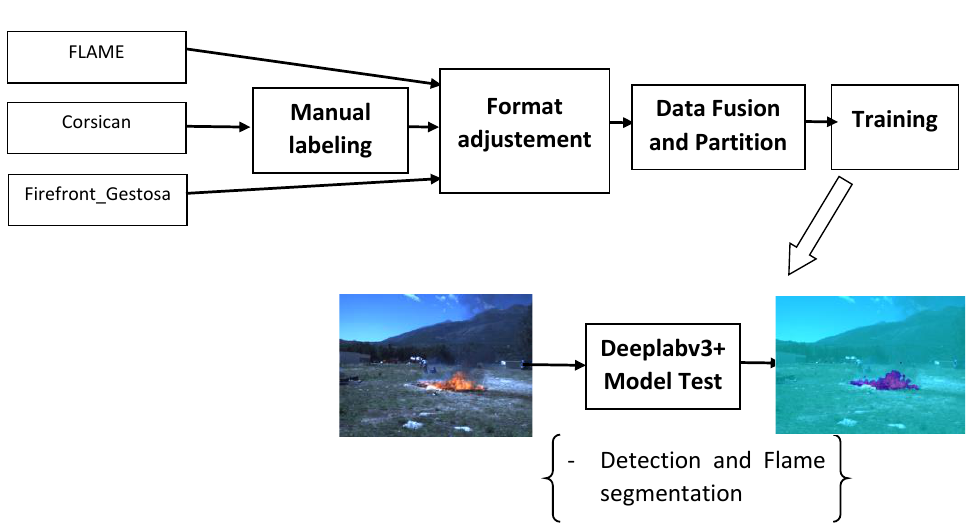
Figure 1. The proposed framework for fire detection. First, the dataset is labeled and correctly formatted; later, the model is trained to locate the flames. Then the deeplabv3+ model is used to generate the segmentation mask.